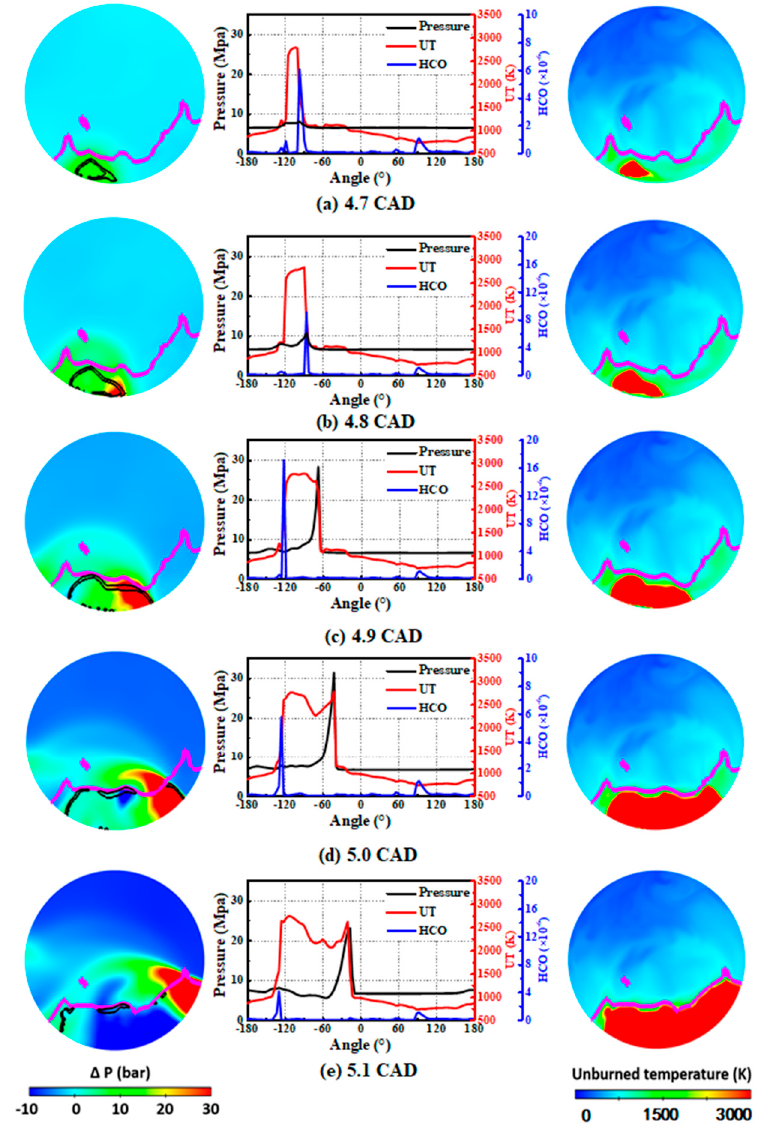
Figure 12. Evolution of 2D pattern of ∆ P in the horizontal cross-section ( left ), pressure, unburned temperature, and mass fraction of HCO on the 1D profile ( middle ) and 2D pattern of unburned temperature in the horizontal cross-section ( right ) under the condition of ω = 0.5.